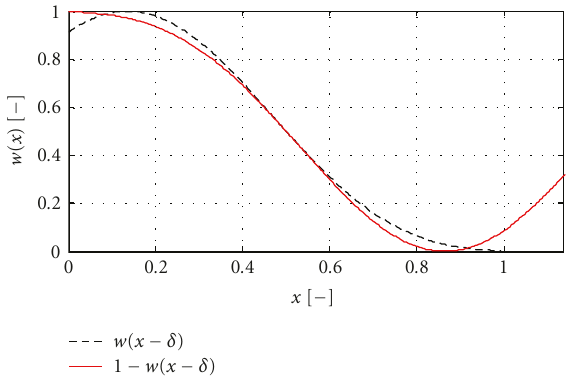
Figure 5: Decomposition of the Nyquist δ -filter frequency response into its upper and lower